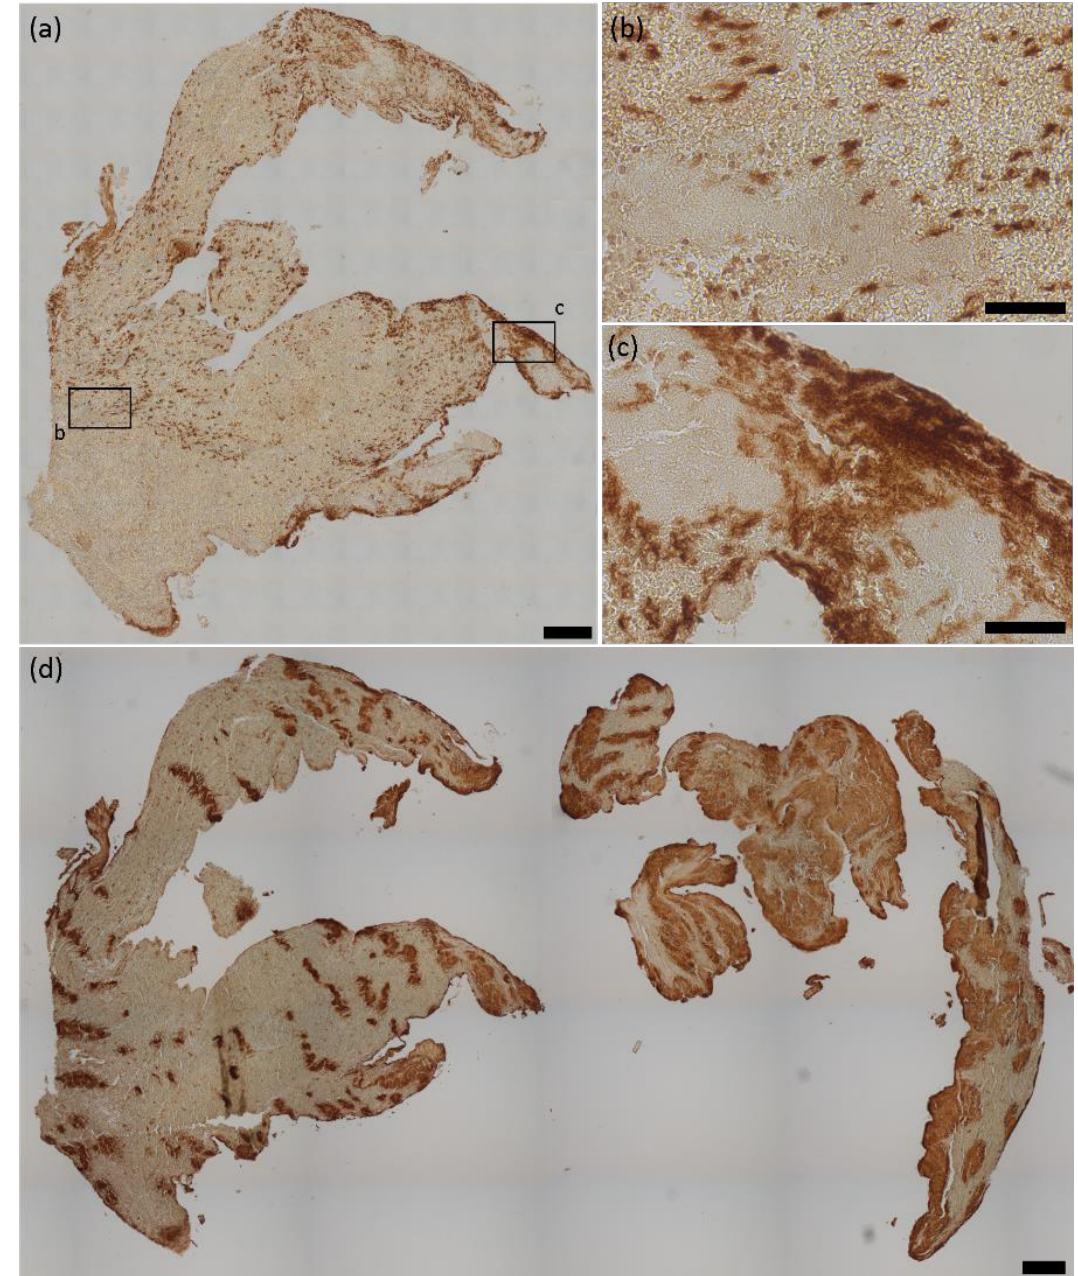
Figure 1. HMGB1 and platelets in cerebral thromboemboli. ( a ) Representative HMGB1 stained thromboemboli and magnifications illustrating the presence of ( b ) small, spotted HMGB1 regions, whereas, especially in peripheral regions, ( c ) extensive areas of HMGB1 were found. ( d ) Representative CD42b stained thromboemboli illustrating the diversity of platelet-rich areas within cerebral thromboemboli. HMGB1 = high mobility group box 1. Scale bars: ( a , d ) 200 µm, ( b , c ) 50 µm.